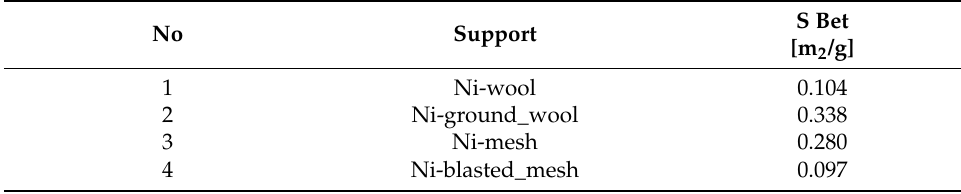
Table 1. Specific surface area (SSA) for the tested supports.